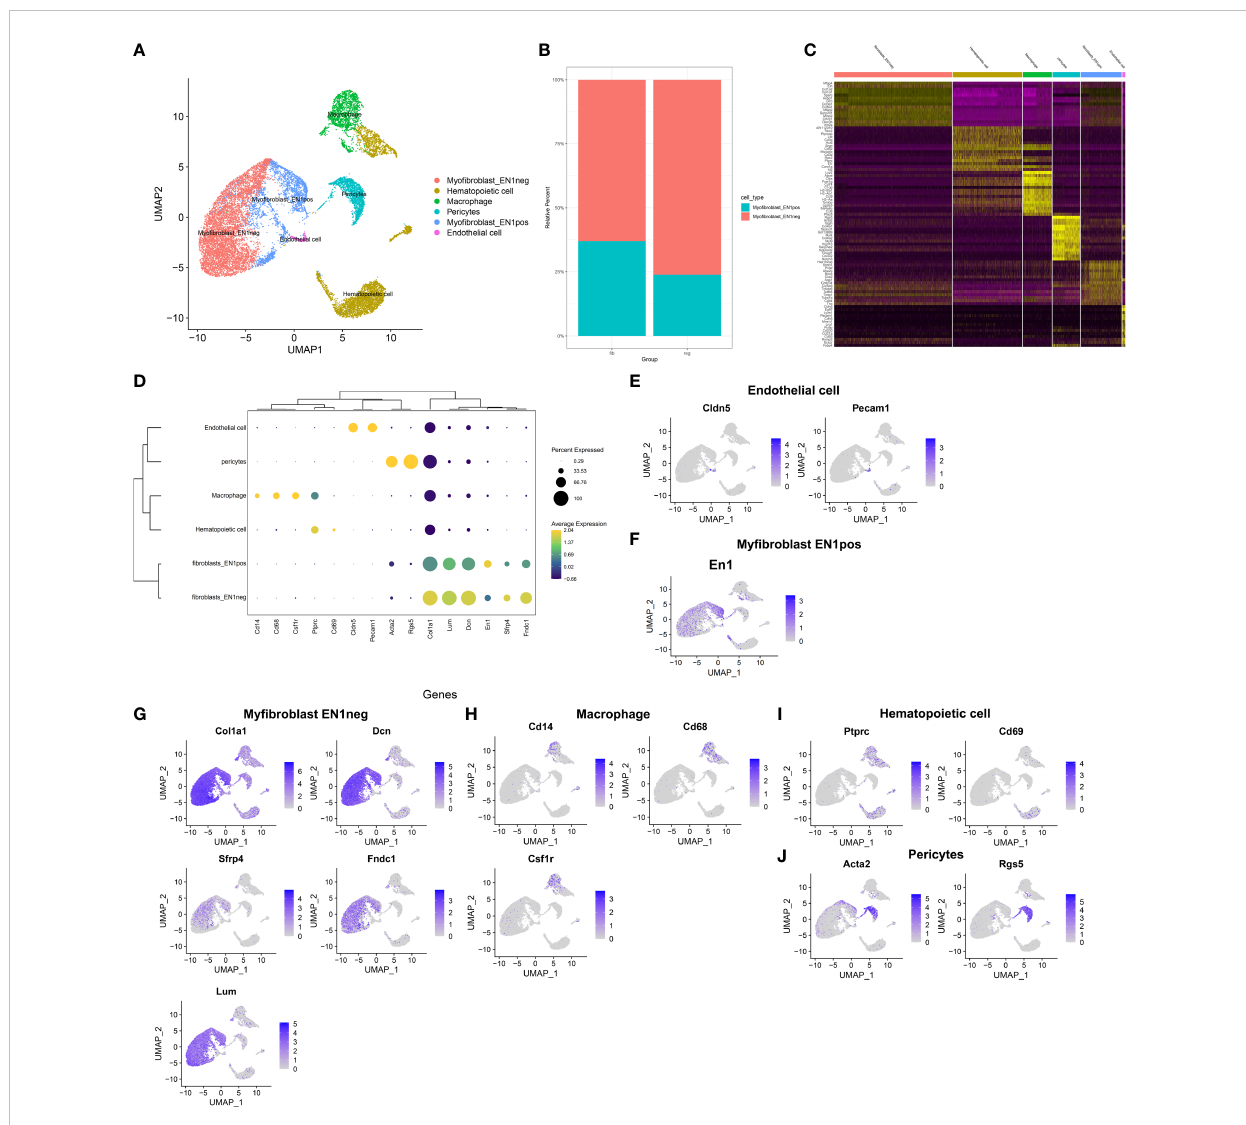
FIGURE 2 Identi fi cation of cell types and their marker genes across fi brotic and regenerative wound dermal cells. (A) UMAP plots showing cell types identi fi ed by marker genes. Each cell type was colored by a unique color. (B) The cell ratio of EN1-negative and -positive myo fi broblasts among fi brotic